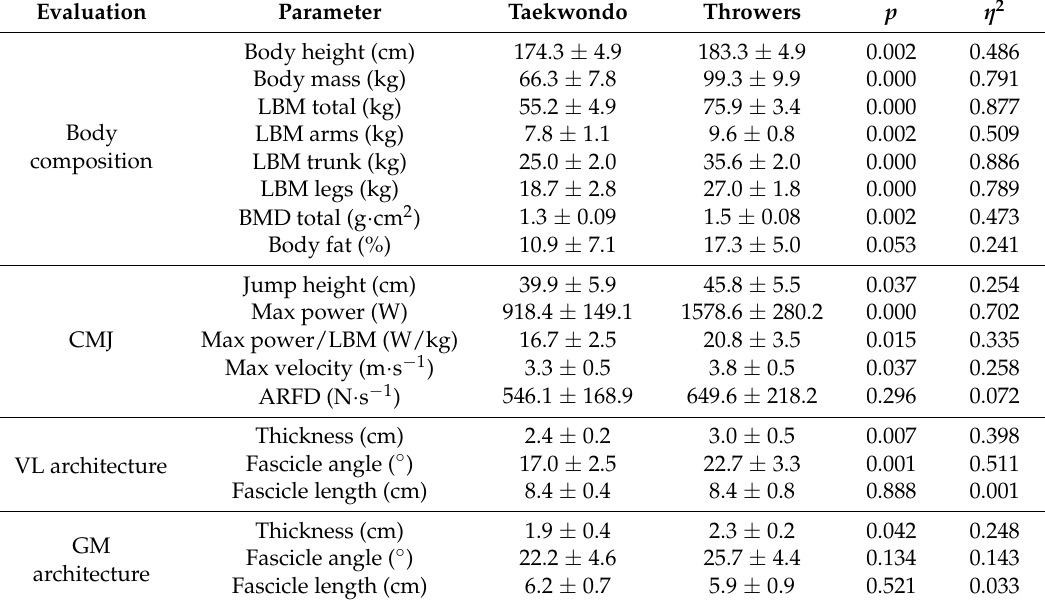
Table 1. Body composition, jumping performance, and muscle architecture in taekwondo athletes ( n = 9) and track and field throwers ( n =